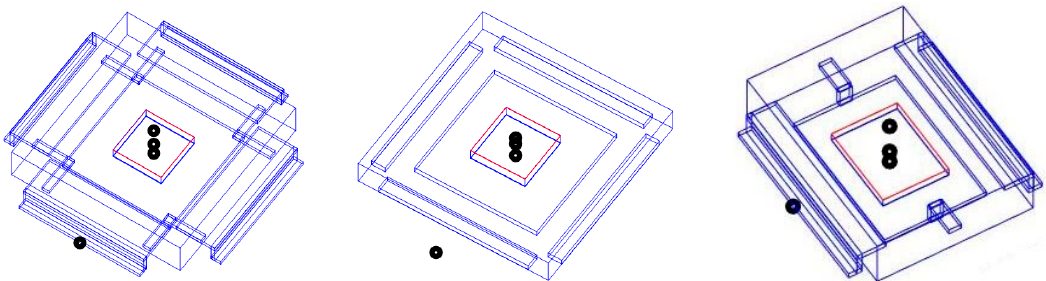
Figure 2. DTMs of the eLQFP (left), single-row eQFN (center), and PowerSSO-36 (right) families. The black circles represent the temperature probes needed to determine the thermal metrics.